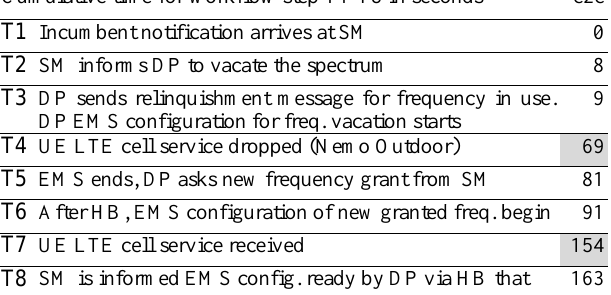
Table 2. LSAevo band reconfiguration measurement